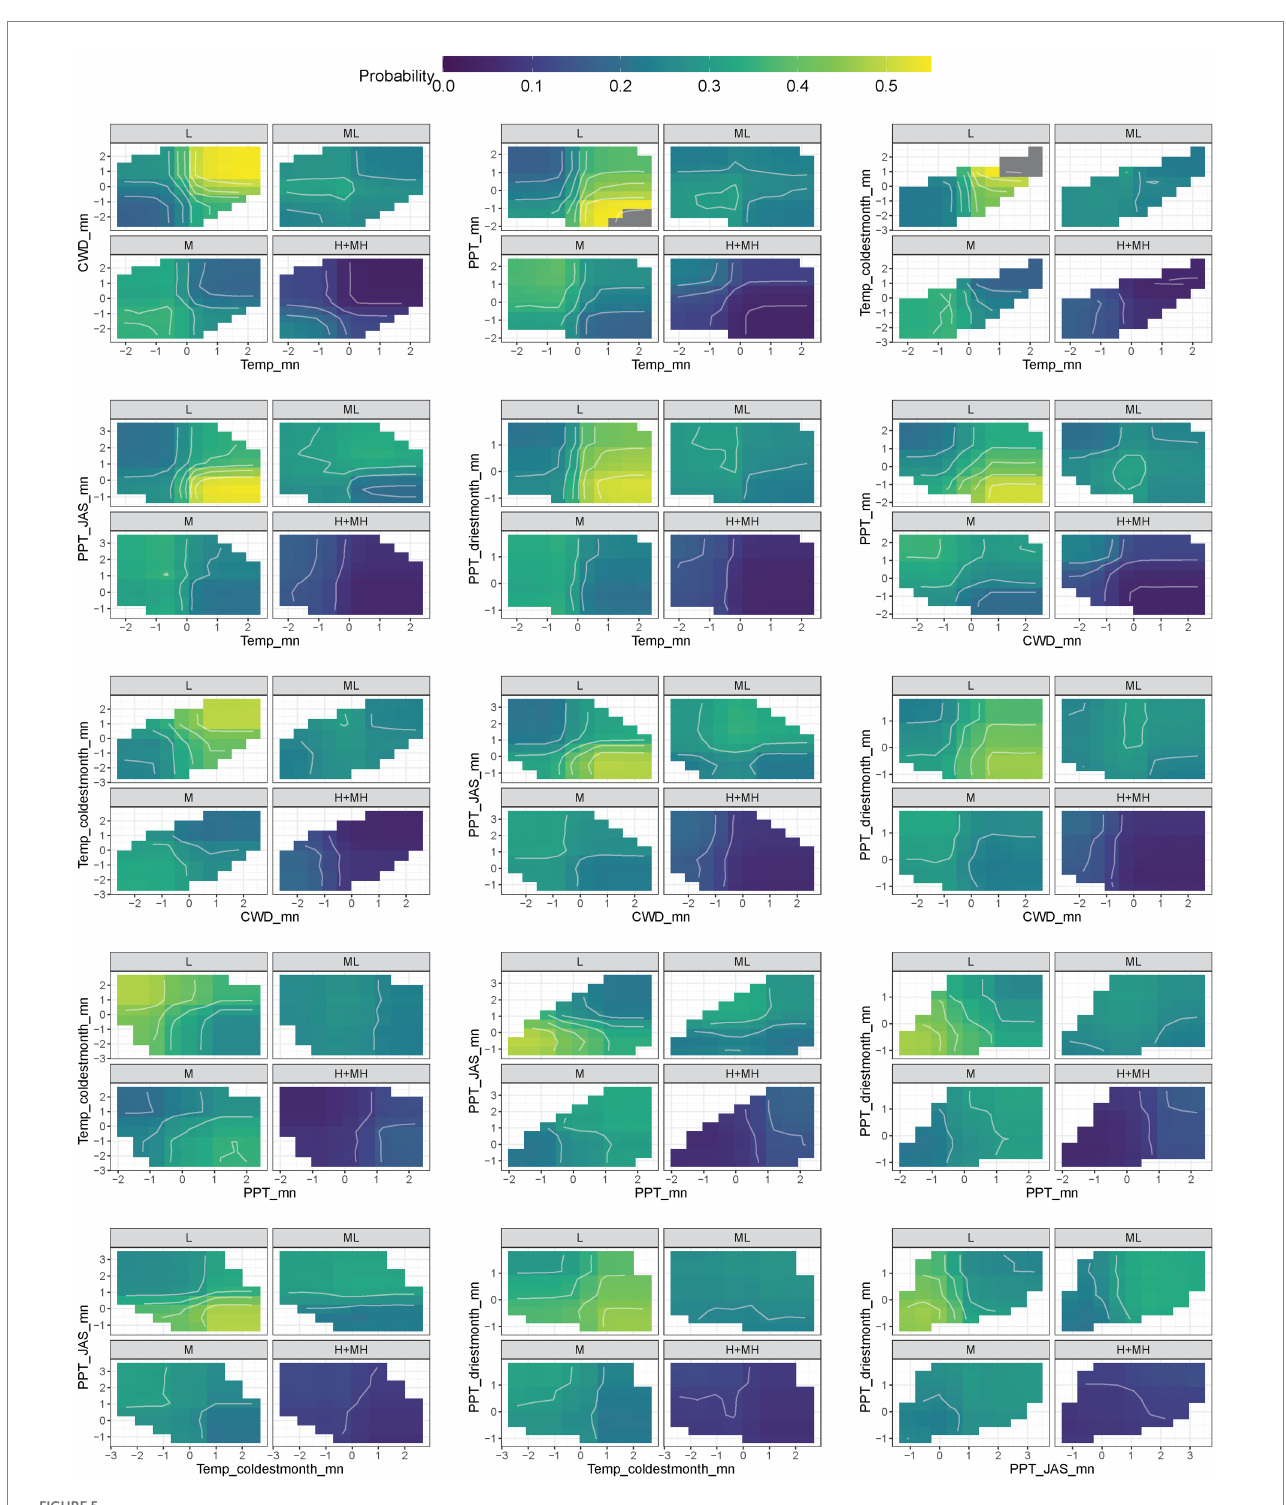
FIGURE 5 Two-way partial dependence plots (PDP) showing interactions between the six most highly ranked indicators for resilience. Lighter colors show higher probability of classification. Units for indicators are centered to a mean of 0 and scaled to unit variance.